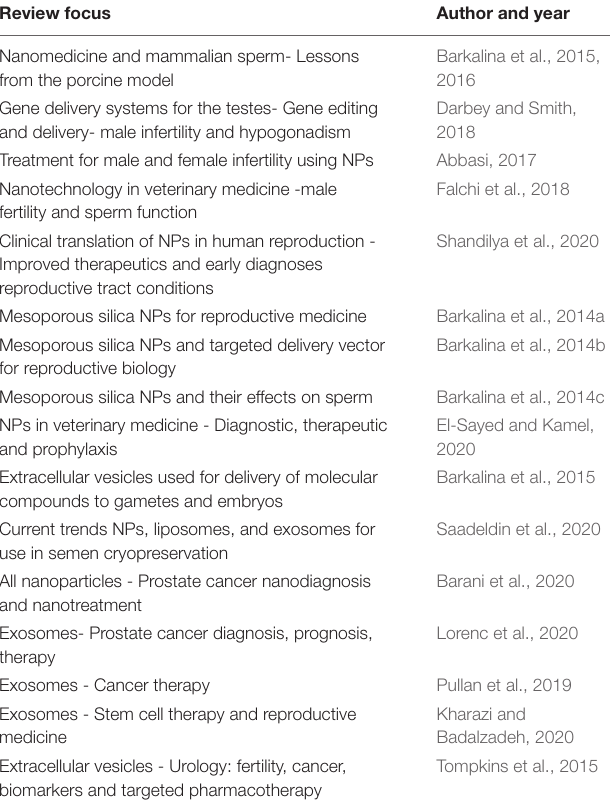
TABLE 1 | Recent review articles exploring nanoparticle use in the male reproductive